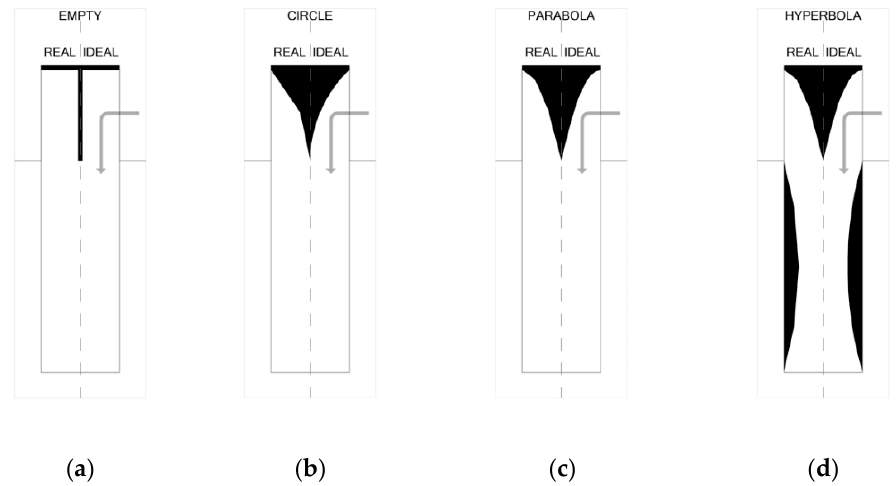
Figure 4. Conception of the wind catcher inlet structure shape; empty’ geometry ( a ); ‘circle’ ( b ); ‘parabola’( c ) and parabola with ‘hyperbola’ bell in the tower ( d ).